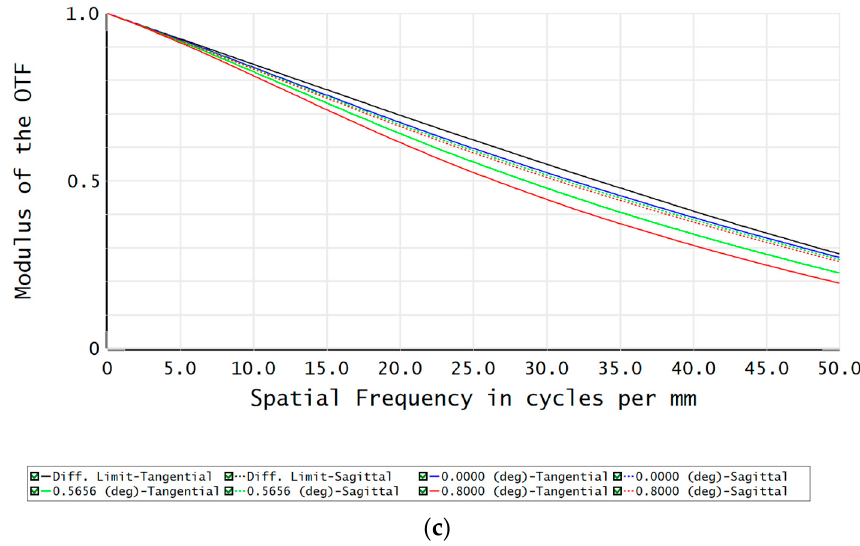
Figure 9. MTF curves of the zoom system: ( a ) Focal length of the zoom system is 88.3547 mm; ( b ) Focal length of the zoom system is 150.096 mm; ( c ) Focal length of the zoom system is 204.62 mm.